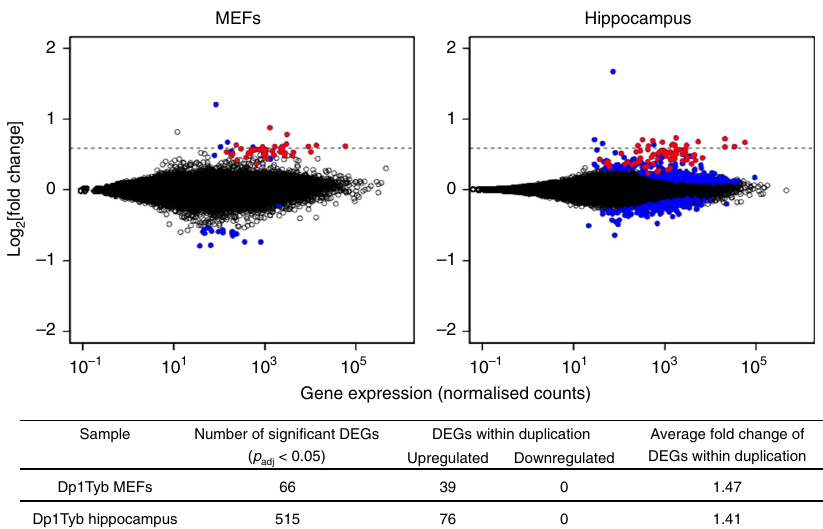
Fig. 1 Differential gene expression in Dp1Tyb mice. Plots of log 2 [fold change] in the expression of each gene in Dp1Tyb mouse embryonic fi broblasts (MEFs, left) or hippocampus (right) compared to wild-type (WT) littermate controls, against mean expression of each gene. Genes are indicated by black circles, except for differentially expressed genes (DEGs, p adj < 0.05) indicated in red if they are within the duplicated region and in blue if outside it. Dashed lines indicate a fold change of 1.5. Table at bottom shows the number of DEGs, the number of DEGs within the duplicated region in Dp1Tyb (all of which were upregulated) and the average fold change of the latter